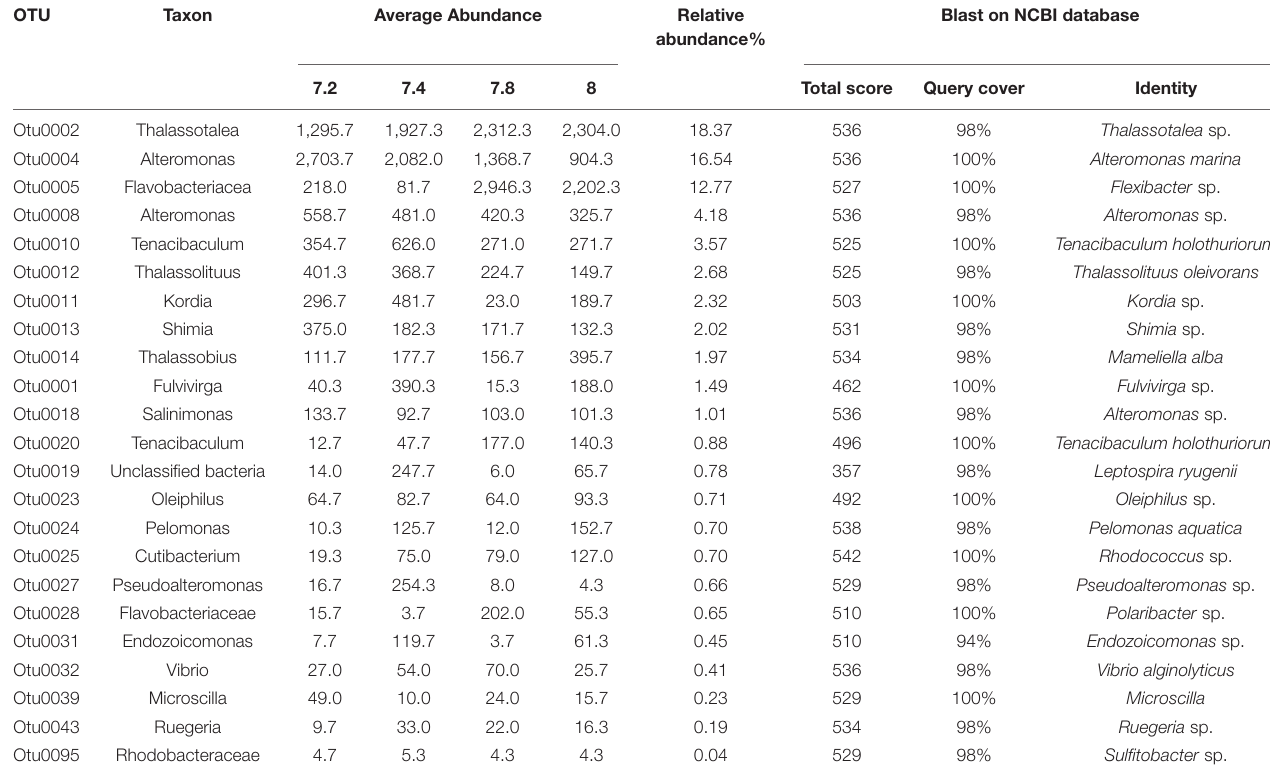
TABLE 2 | Core microbiome of Stylophora pistillata kept in aquaria for 2 years at different pH treatments (7.2; 7.4, 7.8 and